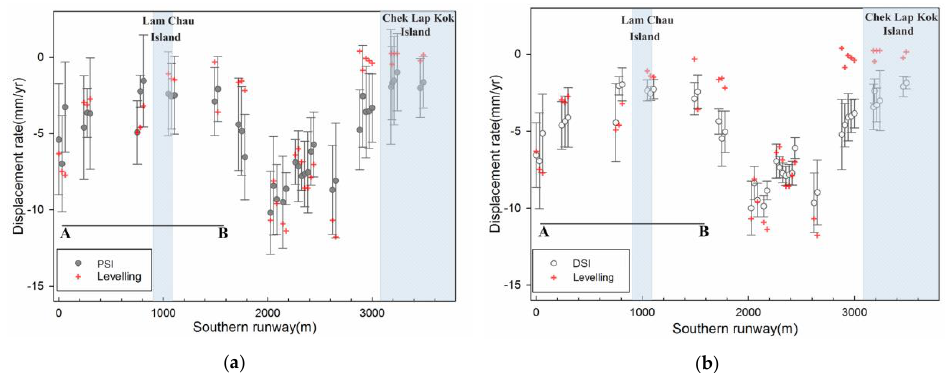
Figure 11. Comparison between the InSAR-retrieved deformation rates and benchmark levelling measurements (represented by white circles in Figure 6b) along the southern runway: ( a ) PSI method, and ( b ) DSI strategy. Grey areas approximately indicate the boundaries of the original islands of Chek Lap Kok and Lam Chau. The segment A – B of the black line shows the location of geological cross-section in Figure 2a.